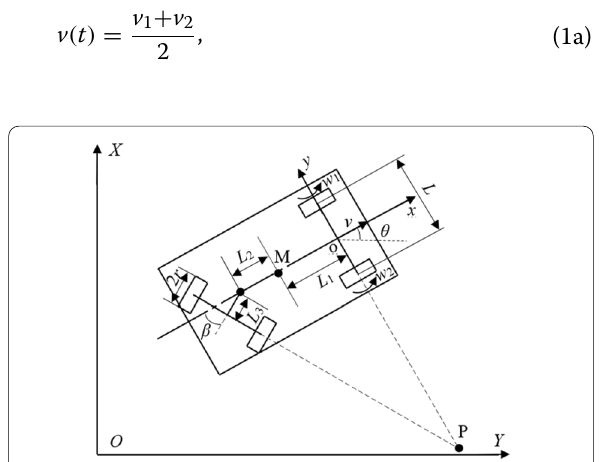
Figure 2 Kinematics model of